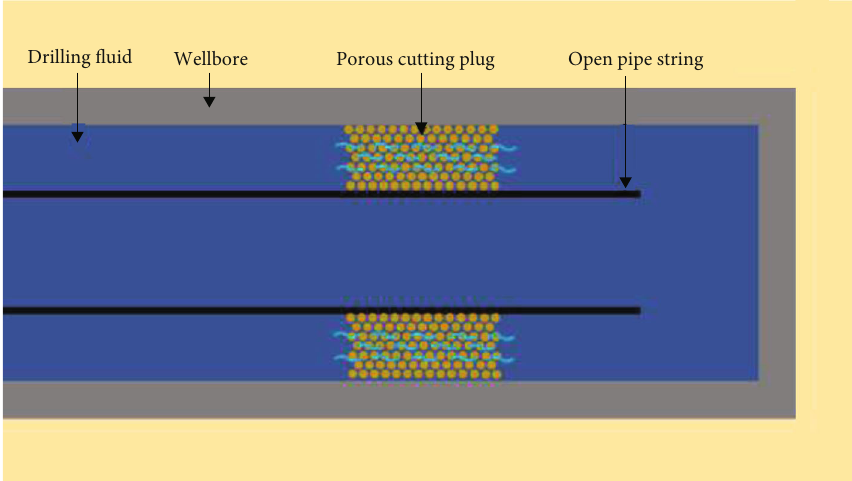
Figure 4: An open pipe string with a porous cutting